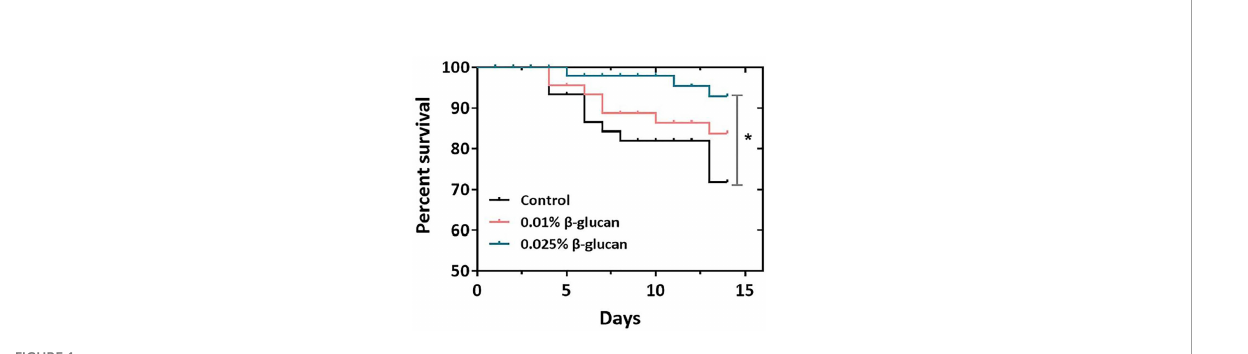
FIGURE 1 Effect of b -glucan on survival rates of zebra fi sh post SVCV infection (n = 3) (survival rates (%) over time, days 0-14). The asterisk denotes signi fi cant difference ( P < 0.05) by Log-rank (Mantel-Cox)